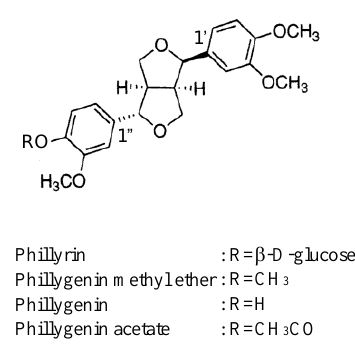
Figure 1. Chemical structures of phillyrin and aglycone derivatives.